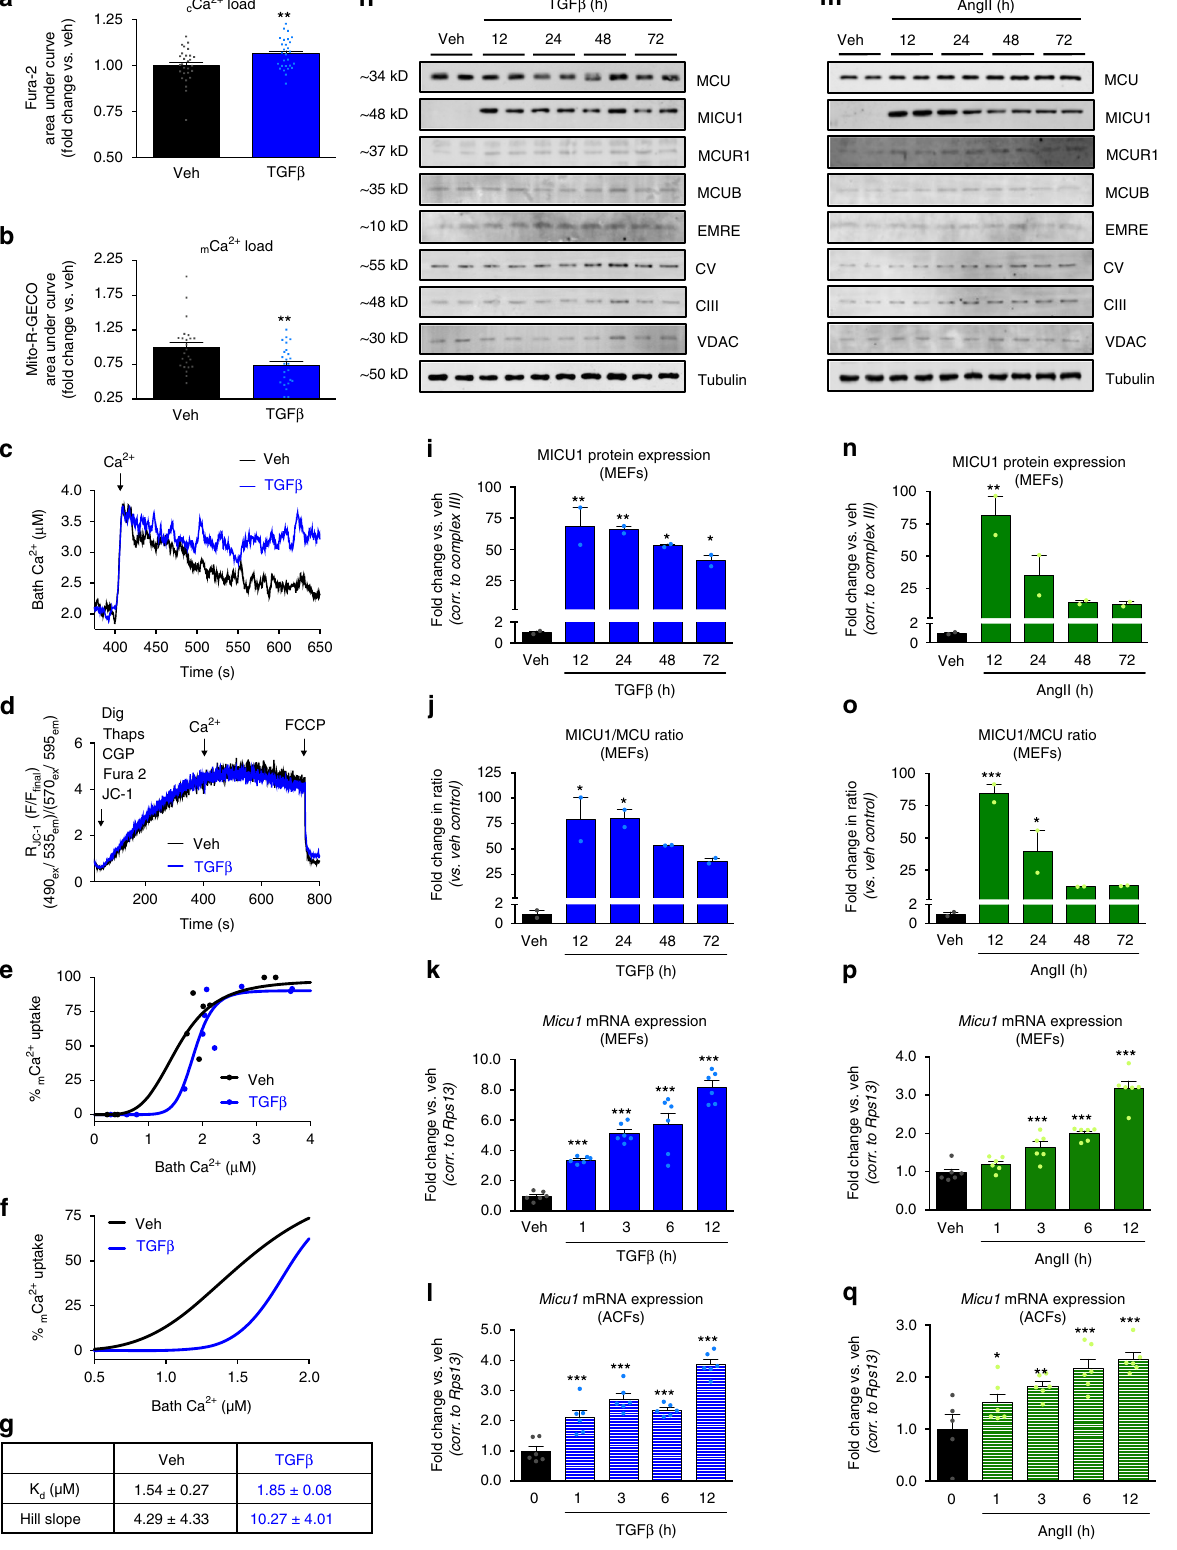
TGF β and AngII (Fig. 3q, r). Inhibition of glycolysis (Ad-Glyco- Low) prevented TGF β -mediated and AngII-mediated differentia- tion and reverted the enhanced differentiation in Mcu − / − fi broblasts back to control levels (Fig. 3s,